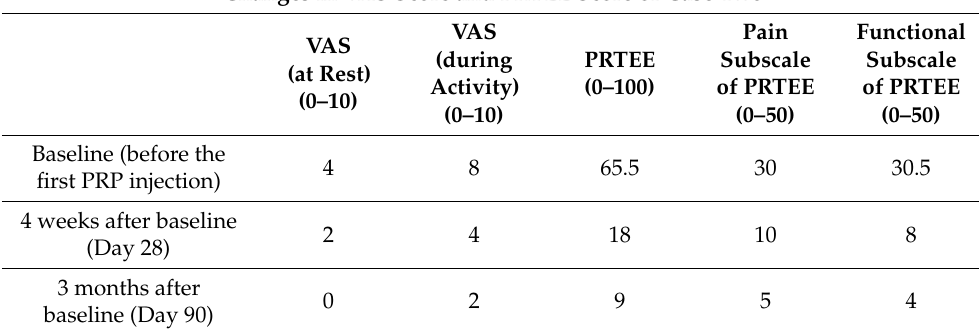
Table 2. Visual analogue scale (VAS) and patient-rated tennis elbow evaluation (PRTEE) scores of a patient with refractory lateral epicondylitis (case two) during baseline (before the first PRP injection) and four weeks or three months after